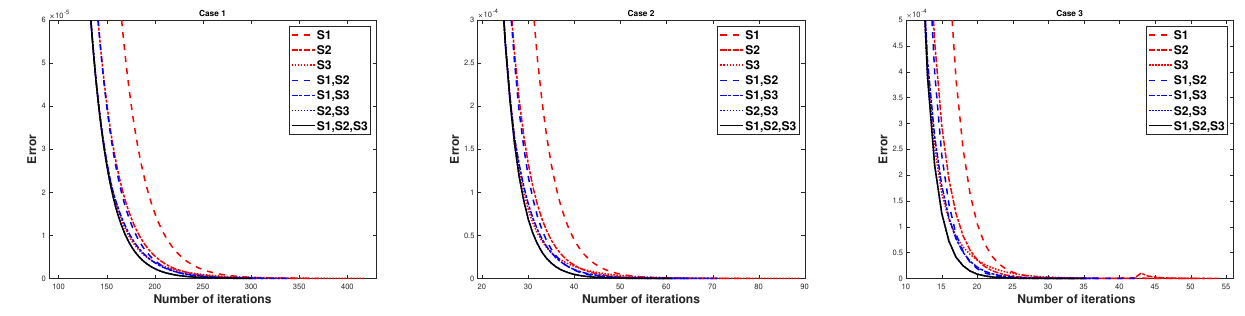
Figure 1. Graph of number of the iterations versus